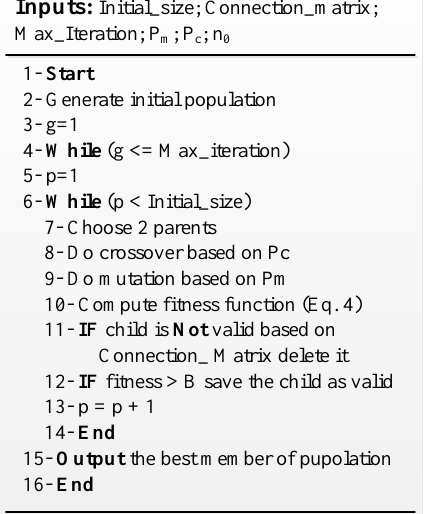
Figure 6 illustrates the pseudo code of the proposed